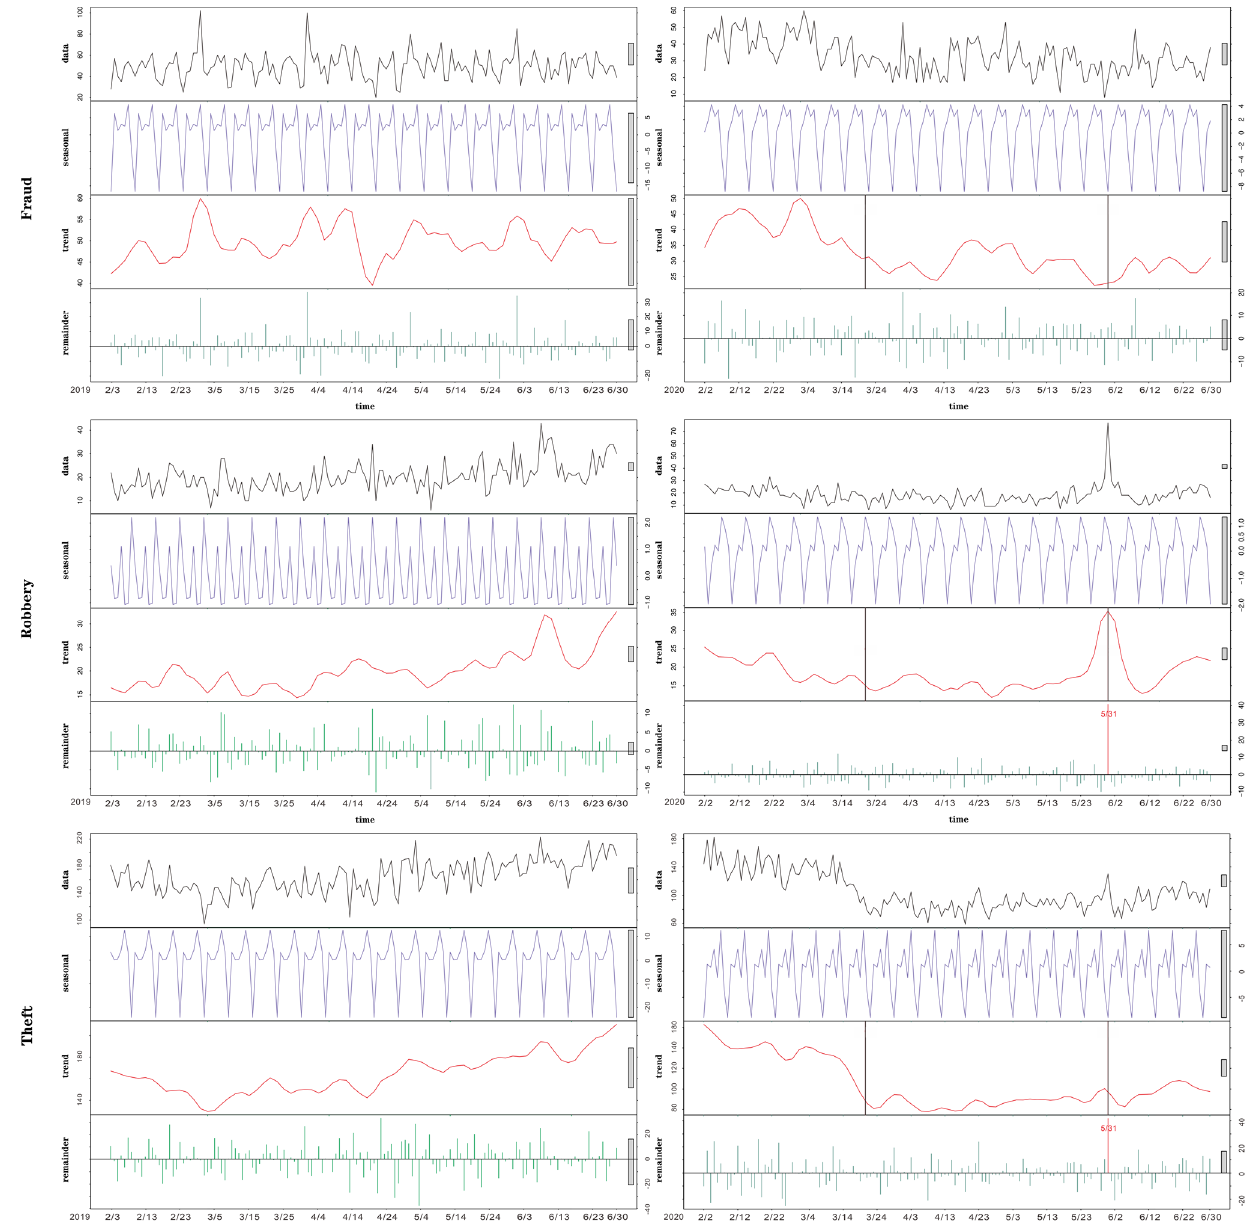
Figure 4. Seasonal-Trend decomposition procedure based on Loess (STL) decomposition for daily crime data (including seven types of crimes) from 1 February to 30 June in both 2020 and 2019. The number of observations of a seasonal cycle is 7. The decomposition includes three components: trend ( red ), seasonal ( violet ), and remainder components ( green ). Black vertical lines in the trend component indicate time nodes that divide the trend into three stages, whereas red vertical lines in the remainder component indicate the largest outliers.